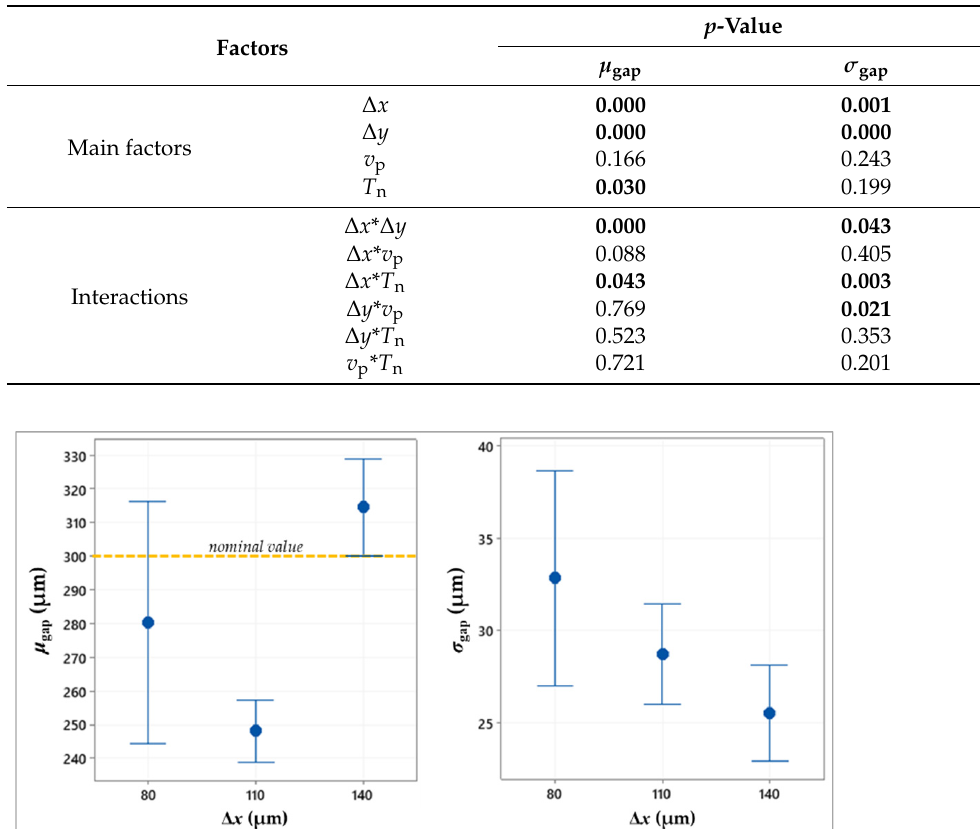
Table 2. ANOVA p -values (bold = significant factor, confidence level α = 5%) for the analysis on the mean value and standard deviation of the gap.